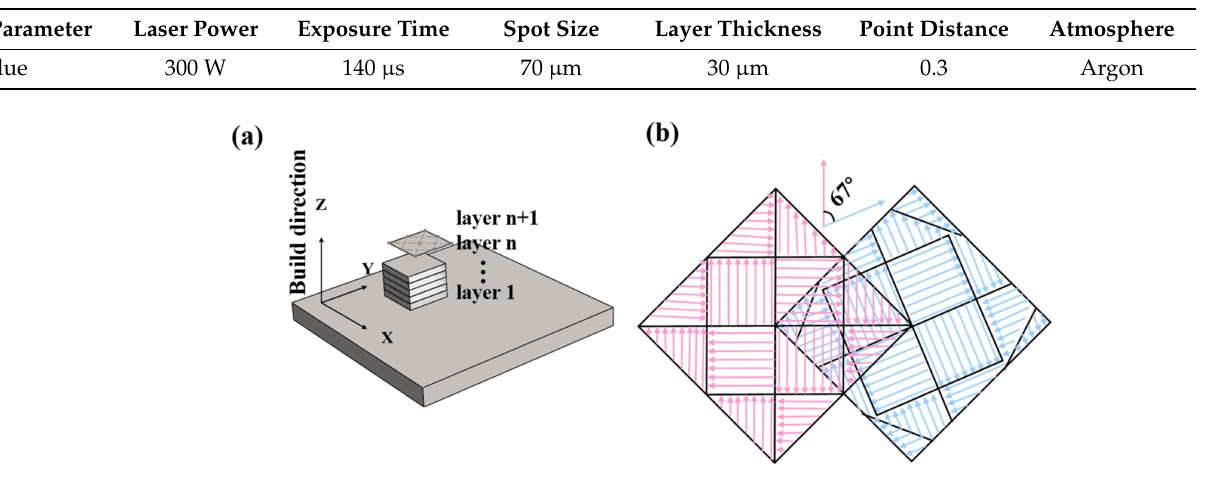
Table 2. Parameters of SLM process.